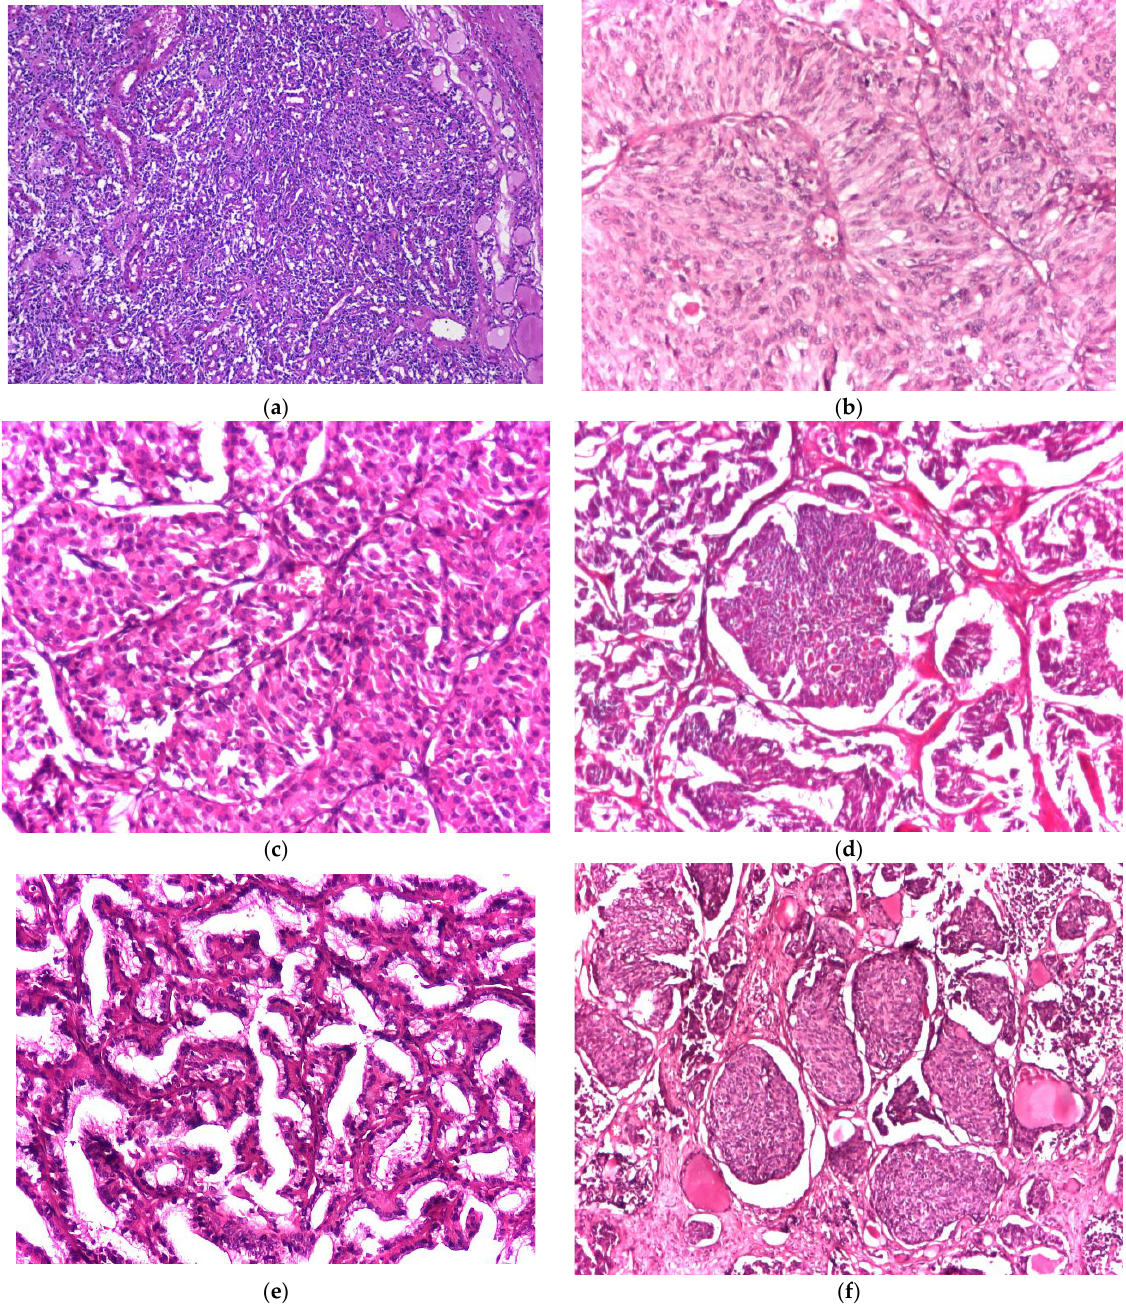
Figure 1. ( a – e ) Histological variants of medullary thyroid carcinoma: ( a ) conventional variant (hematoxylin and eosin — H and E, magnification 4×), ( b ) spindle cell variant (hematoxylin and eosin — H and E, magnification 20×), ( c ) oncocytic variant (hematoxylin and eosin — H and E, magnification 20×), ( d ) follicular/glandular variant (hematoxylin and eosin — H and E, magnification 4×), ( e ) pseudopapillary variant (hematoxylin and eosin — H and E, magnification 10×), and ( f ) small cell variant (hematoxylin and eosin — H and E, magnification 4×). The lymphovascular invasion was present in 34 cases (57.62%), including four cases of familial MTC. Perineural invasion was noticed in two cases (3.38%) of sporadic MTC.